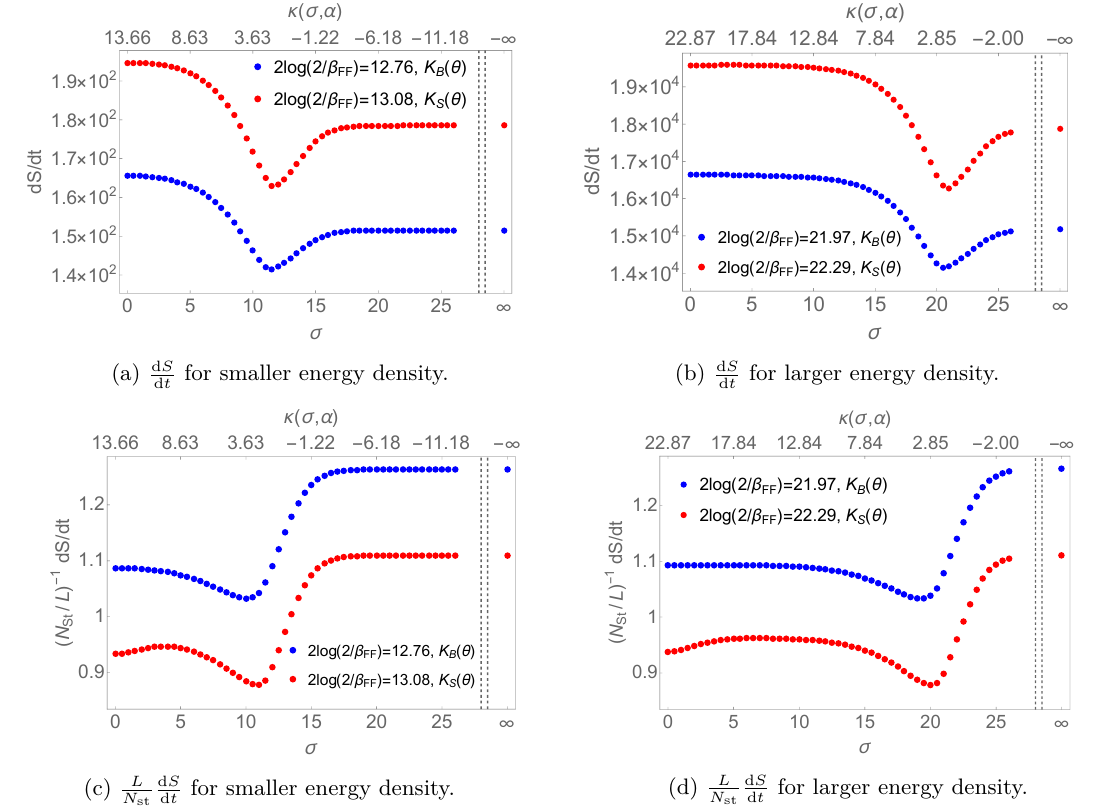
Figure 7 . The entropy production rates d S /d t without and with normalisation by N st { L against the resonance parameter σ . We consider quenches with different K -functions ( K in blue, K B p θ q S p θ q in red) and various fixed injected energy densities against the resonance parameter σ . The injected energy density corresponds to the same free fermion inverse temperatures as in figure 5. The bottom and top labels show the values of σ and of κ p σ, α q “ κ , respectively, where the B p σ, α q « κ S p σ, α q largest difference between κ and κ is 0 . 05 . A local minimum is seen at a value of σ “ σ which B S min is slightly below σ “ 2 log 2 { β . The precise numbers are reported in table 3. FF